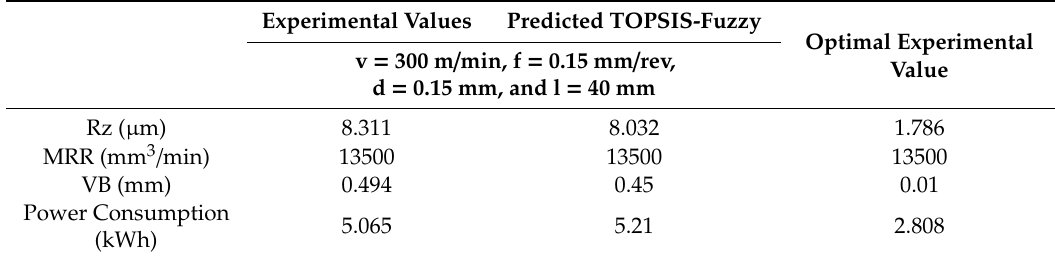
Table 5. Results validation and comparison with the optimal experimental